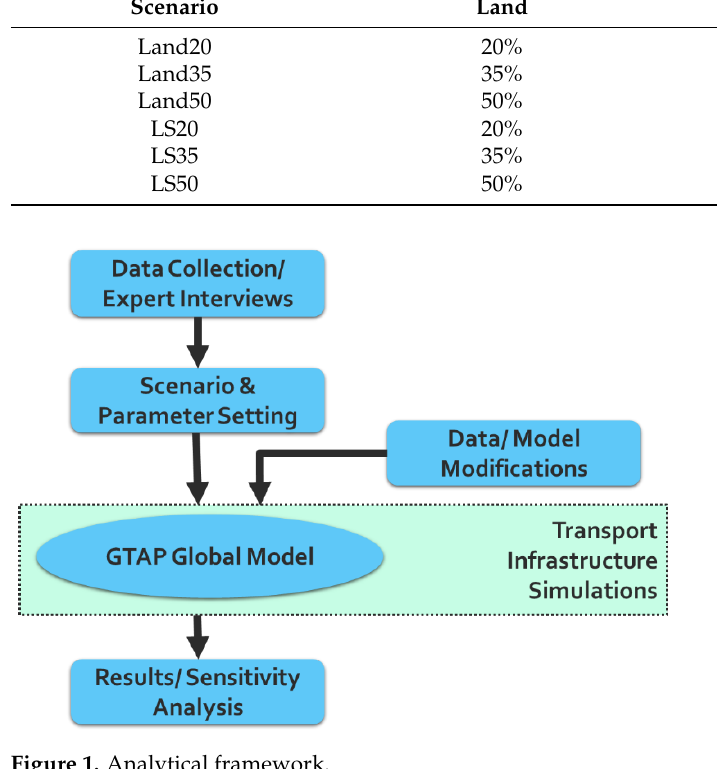
Table 2. Land/Sea Trade Ratios used for Price Shocks under Different Policy Scenarios.